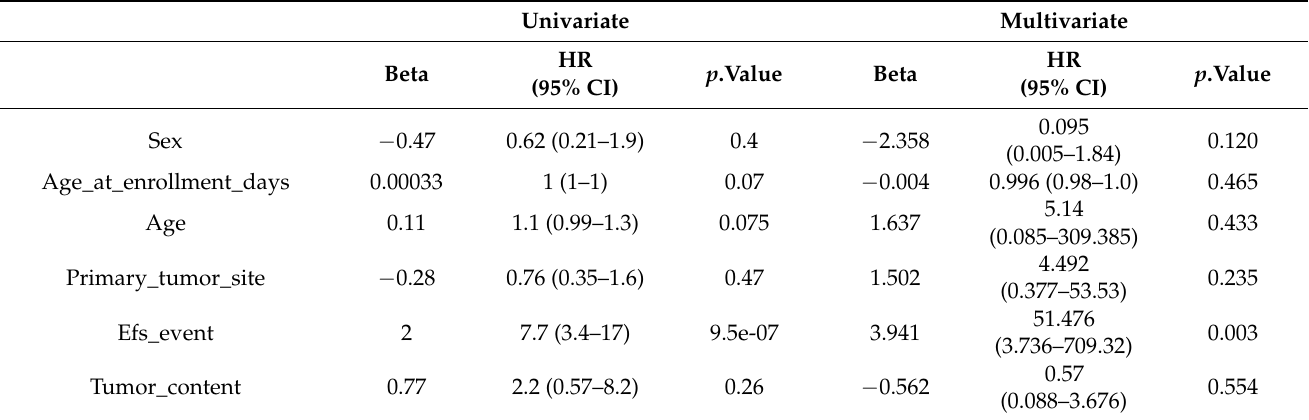
Table 1. Univariate and multivariate Cox analysis of the correlation clinical factors with OS in patients with ES. Univariate Multivariate